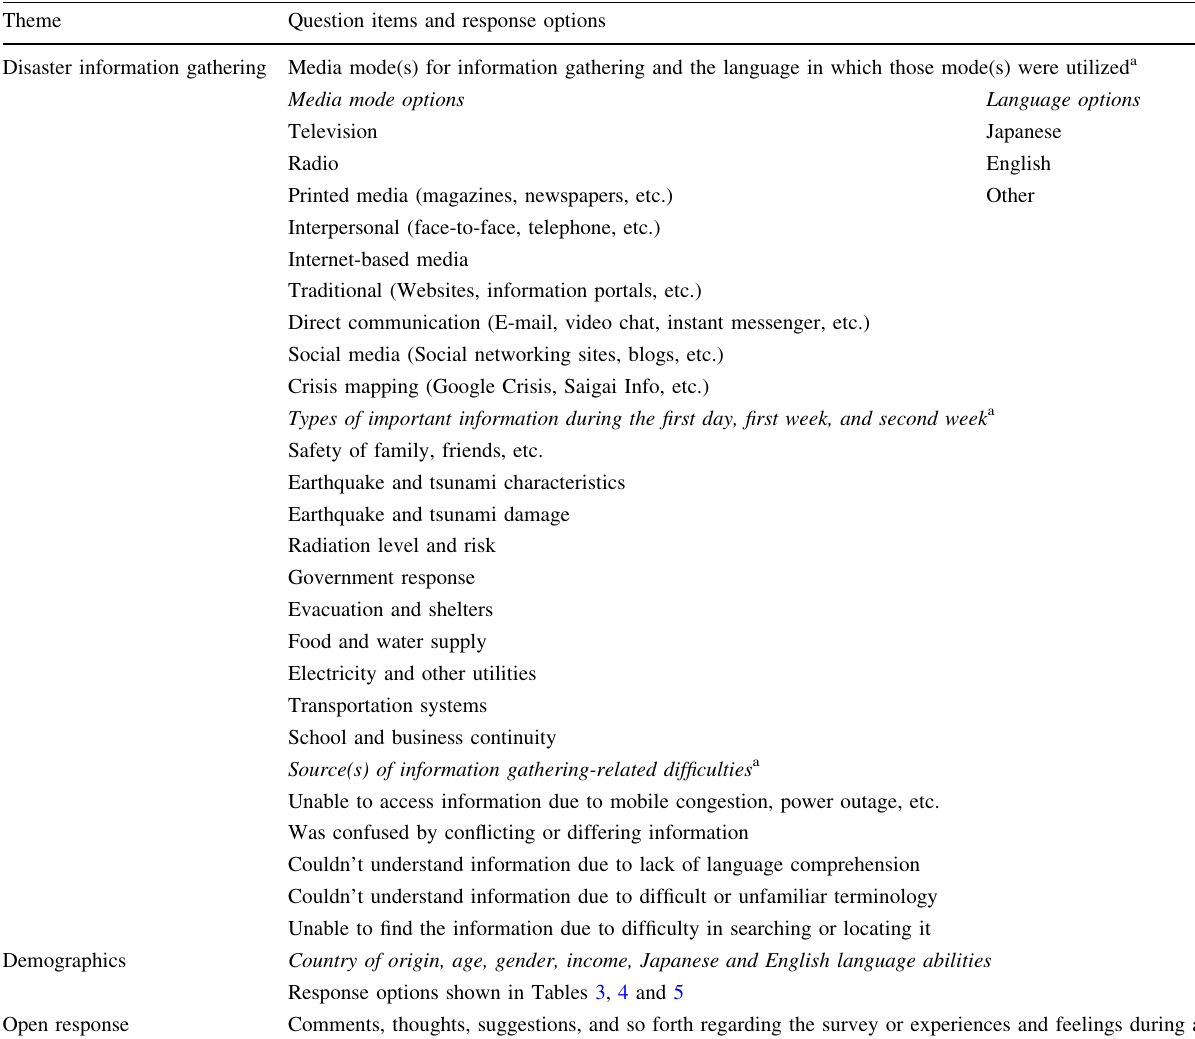
Theme Question items and response